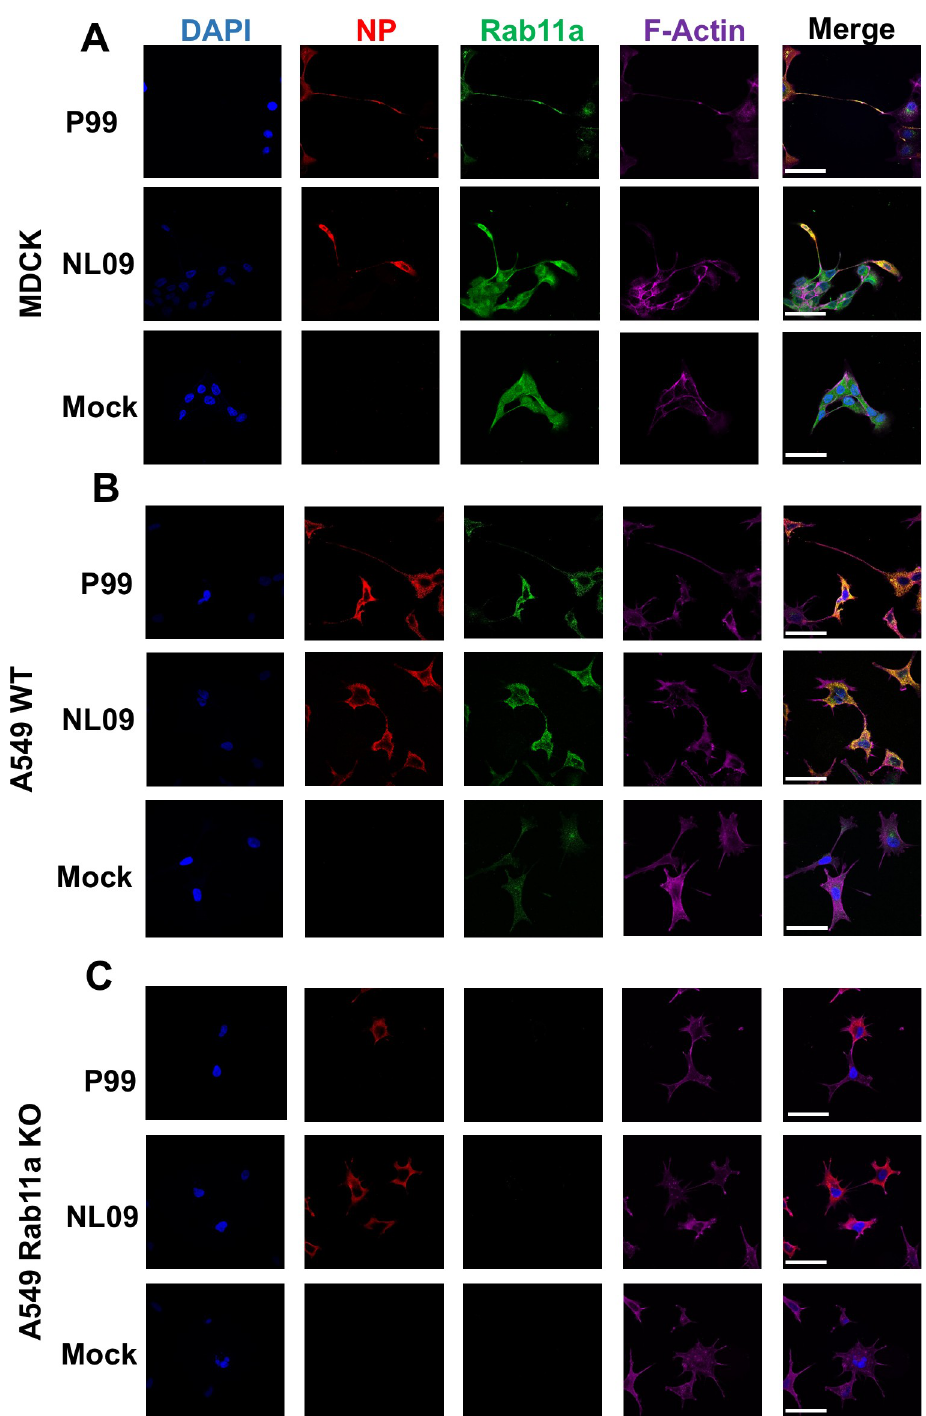
Fig 1. IAV vRNPs associate with Rab11a in F-Actin rich TNTs. [A] MDCK cells,[B] A549 WT and [C]A549 Rab11a KO cells were mock-infected or infected with NL09 or P99 viruses. Cells were stained for DAPI [blue], NP [red], Rab11a [green] and F-Actin [pink]. Representative images are shown withadditional images in S1–S3 Figs. Scale bar is 20 μ m for all images.